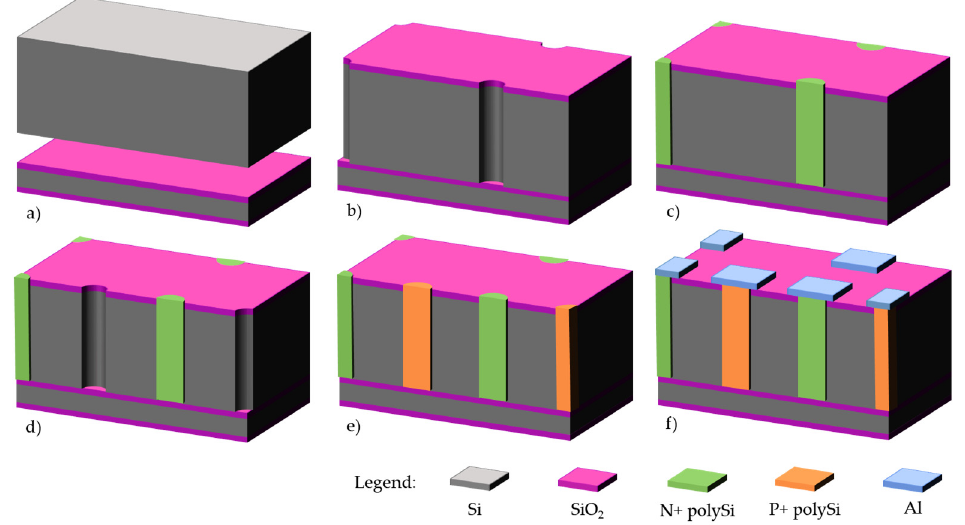
Figure 10. Stanford original process on n-type silicon wafers: ( a ) fusion bonding of oxidized support wafer with active wafer; ( b ) field oxidation, n+ window patterning and DRIE of n+ electrodes; ( c ) polysilicon deposition and n+ doping; followed by undoped polysilicon filling; ( d ) pattern and etching of p+ window, and DRIE of p+ electrodes; ( e ) polysilicon deposition and p+ doping; followed by undoped polysilicon filling; ( f ) metal deposition and patterning. Vertical and horizontal scales are different, and support wafer is not to scale.